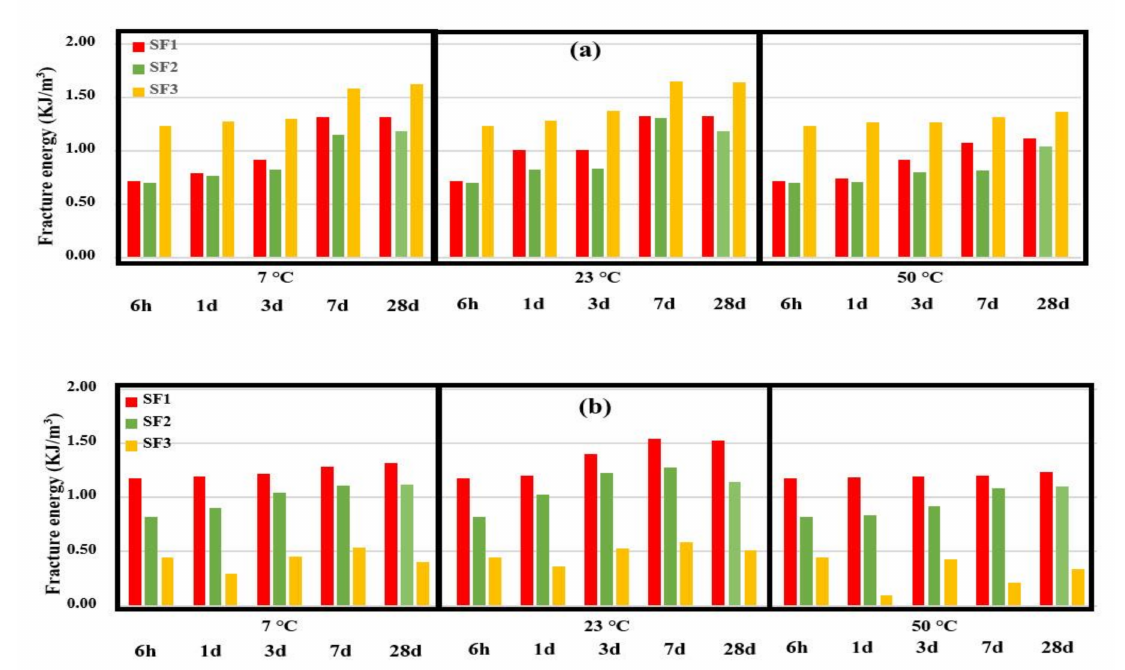
Figure 16. Fracture energy of reinforced CC with spacer fabrics, ( a ) warp direction, and ( b ) weft direction up to ε f